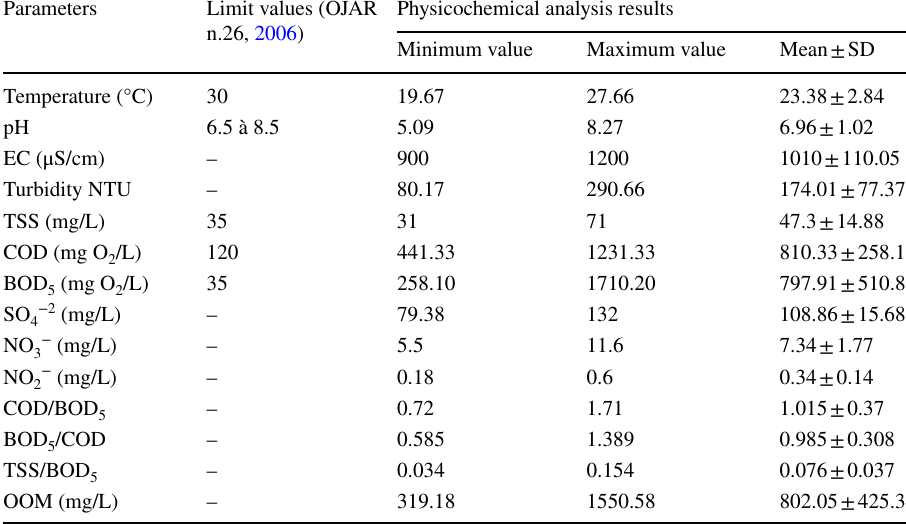
Table 2 Physicochemical parameters’ limit thresholds of industrial liquid effluent discharges (OJAR n.26, 2006), and results of the analyzed